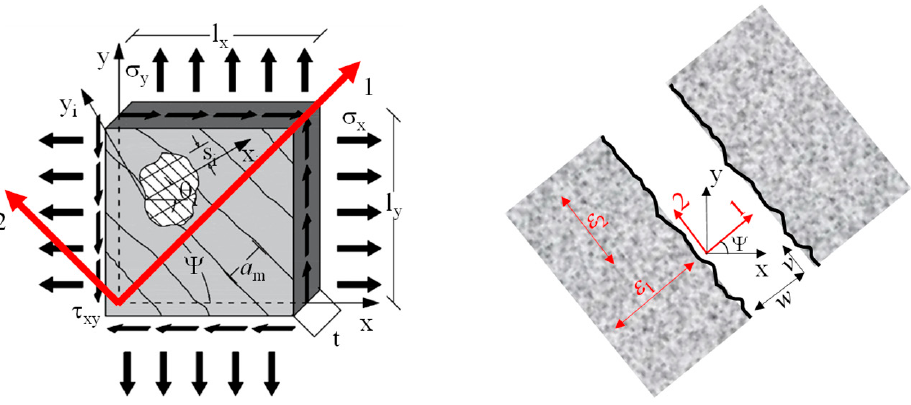
Figure 1. Plane stress state of a RC element and crack pattern.